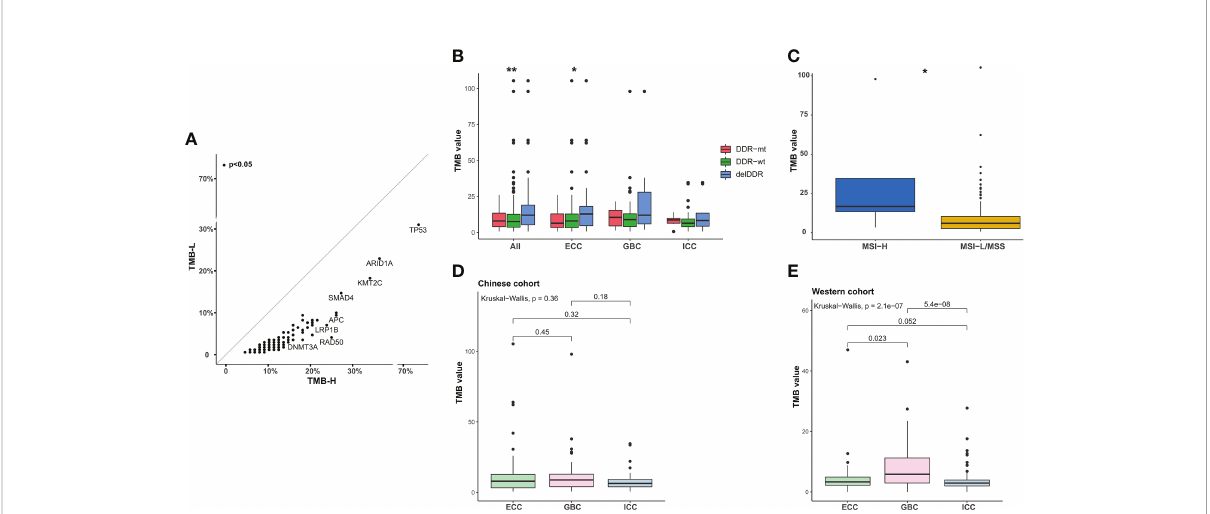
FIGURE 7 Analysis of TMB in BTC patients. (A) Scatter plots of the prevalence of altered genes in TMB-H and TMB-L samples from the Chinese cohort. TMB-H, TMB value ≥ 10 mutations/Mb; TMB-L, TMB value < 10 mutations/Mb. (B) Comparison of the TMB in patients with delDDR, DDR-mt, and DDR-wt. * p < 0.05; ** p < 0.01. (C) Correlation between TMB value and MSI value. According to the median MSI value of BTC patients, patients were divided into the MSI-H group and the MSI-L/MSS group. * p < 0.05. (D, E) Differences in TMB values between ICC, ECC, and GBC subtypes in the Chinese and Western cohorts. TMB, tumor mutational burden; TMB-H, high TMB value; TMB-L, low TMB value; DDR, DNA damage repair; delDDR, deleterious DDR; DDR-mt, DDR mutation; DDR-wt, DDR wild type; MSI, microsatellite instability; ICC,